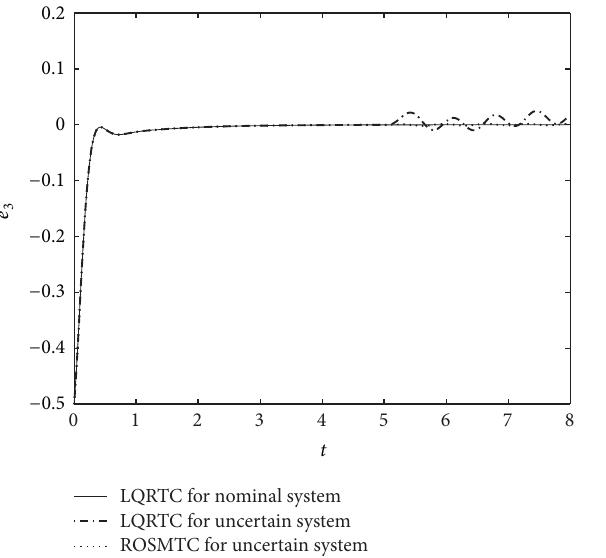
Figure 6: The tracking response curve of the position 𝑞 1 for link 1.